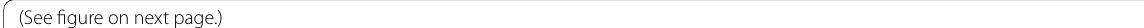
Fig. 8 51-year-old-female COVID-19 positive patient presented with impaired level of consciousness, A , B T2 WI, C , D FLAIR, E , F SWI, G , H DWI and I , J ADC map showing bilateral thalamic, bilateral occipital subcortical, bilateral temporal cortical and subcortical T2 and FLAIR hyperintense SI with restricted diffusion (hyperintense in DWI and hypointense in ADC map) represented acute necrotizing encephalopathy without hemorrhage, with left putamen